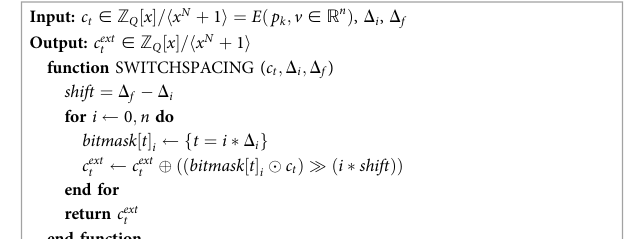
Algorithm 5 Initial Representation and Result Transformation for Diagonal Matrix